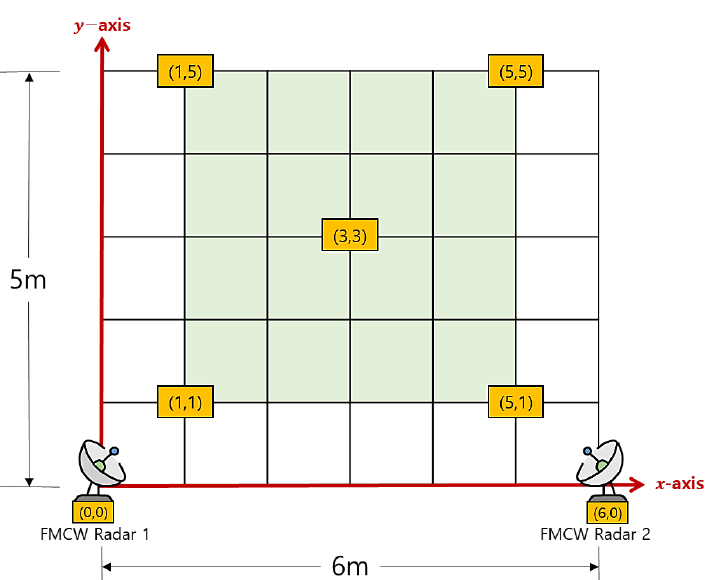
Figure 1. Schematic of two-dimensional (2D) localization system with frequency-modulated contin- uous wave radar.